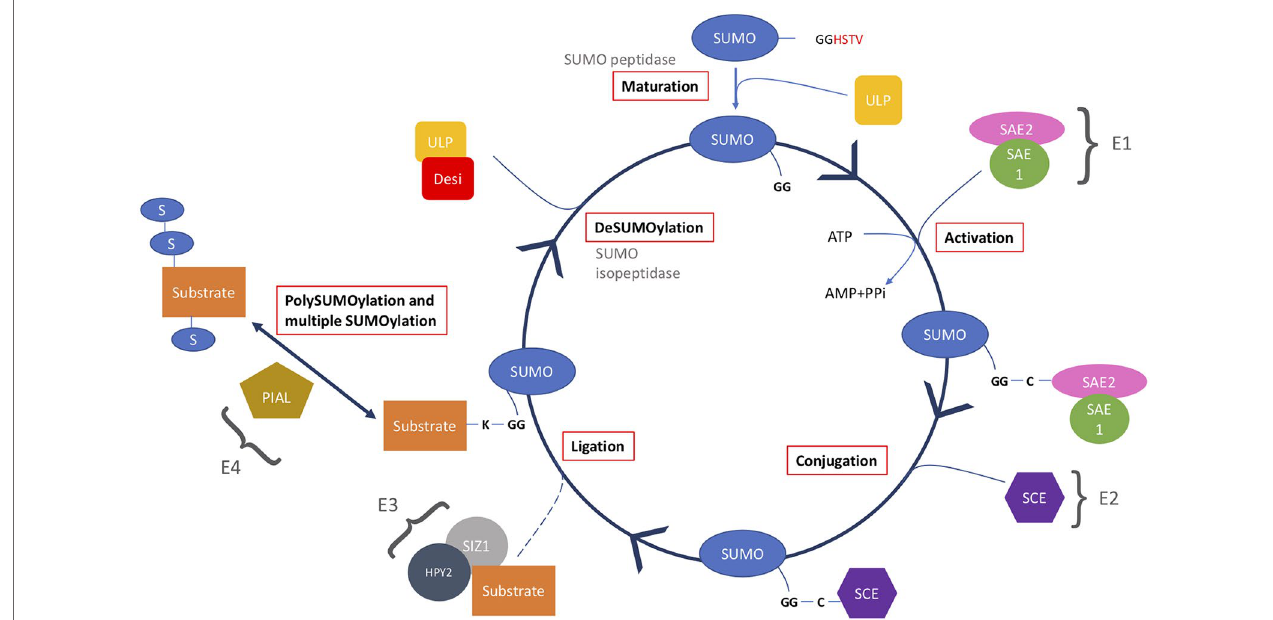
FIGURE 2 | The SUMO cycle starts with maturation of immature SUMO by cleaving off the C-terminus using a SUMO peptidase. Mature SUMO is then activated using ATP and a heterodimer of SAE1 and SAE2. The SUMO is then passed to SCE in a conjugation step, and using a SUMO ligase is ligated onto the substrate. This substrate can then be SUMOylated at more than one SUMO site or form a polySUMO chain. Lastly, in the deSUMOylation step, SUMO is removed from the substrate using a SUMO isopeptidase to generate free